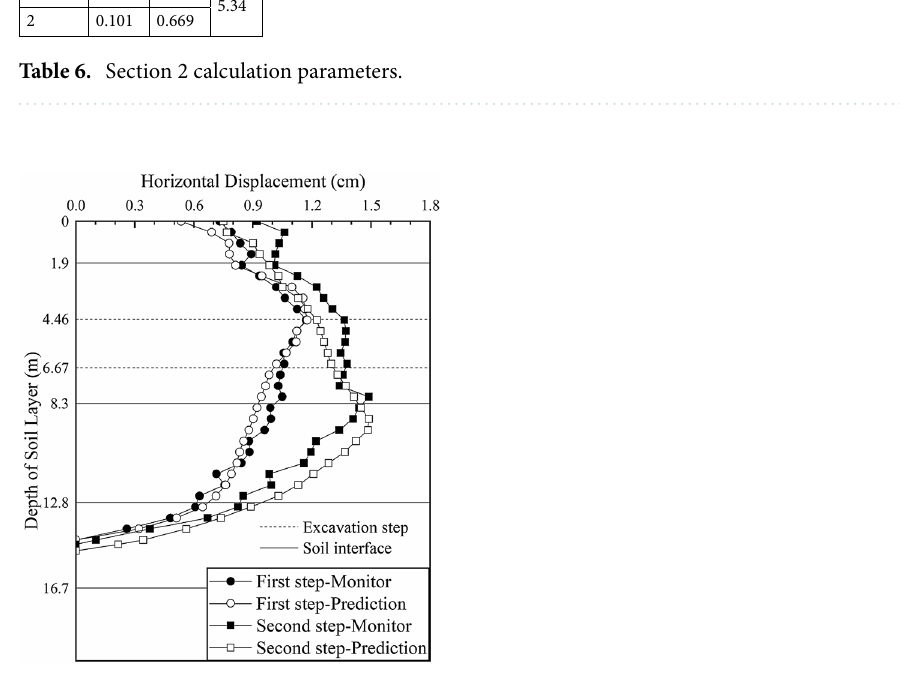
Figure 11. Deep horizontal displacement of section 2 after the